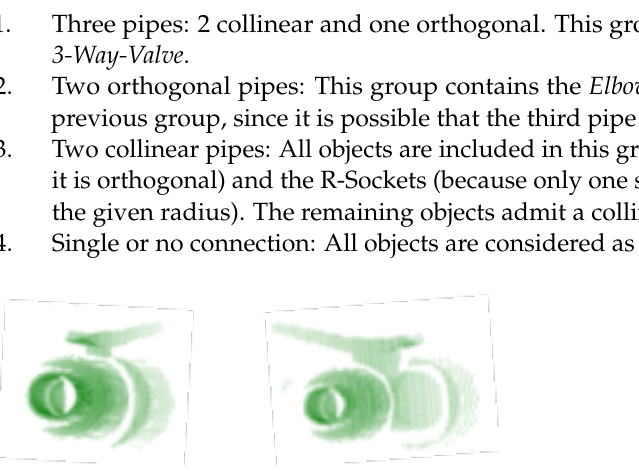
Figure 10. Confusing Views of the Ball-Valve and 3-Way-Valve objects. Algorithm 5: Semantic-based